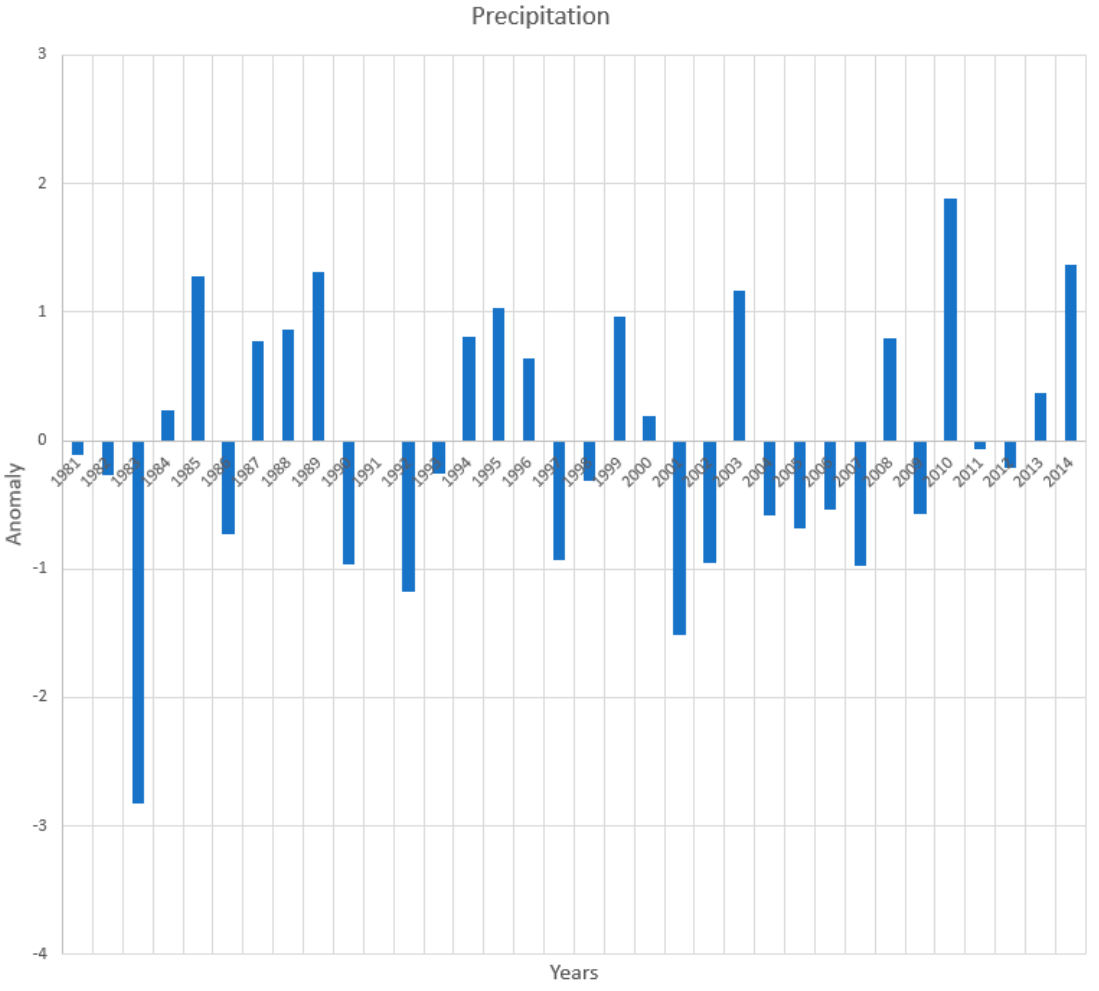
Figure B1. Rainfall (GPCP) anomaly over Bandama basin. 230 Figure A1. Rainfall (GPCP) anomaly over Bandama